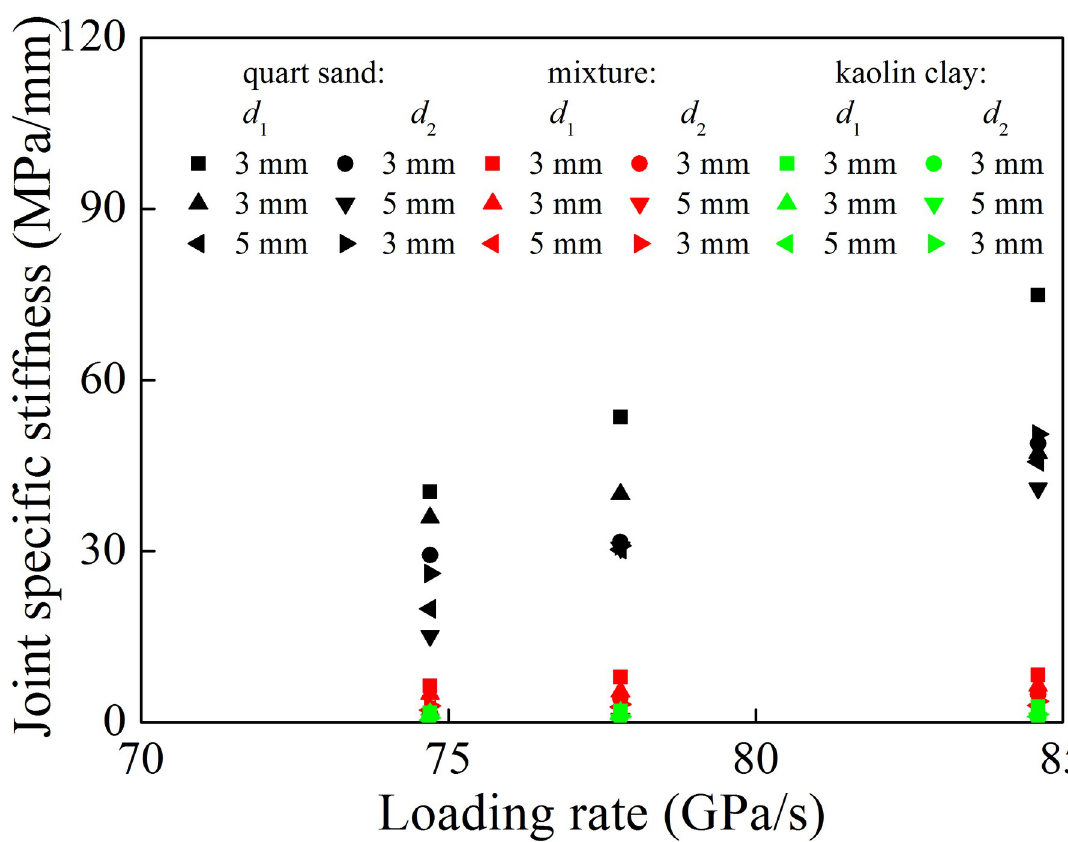
Fig 17. Variation of joint specific stiffness with the loading